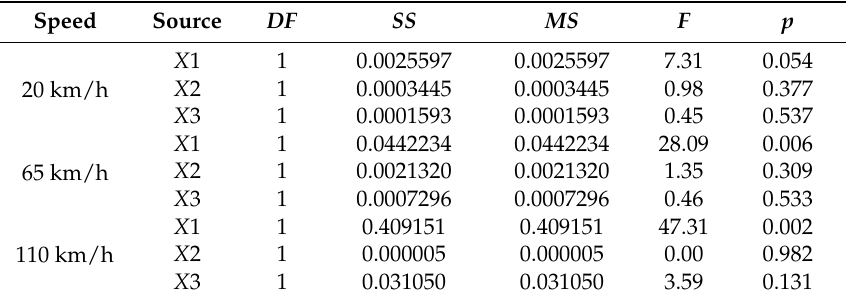
Figure 10. Results of min–max difference (%) in each speed condition. Table 13. ANOVA result with only main factors at three speed